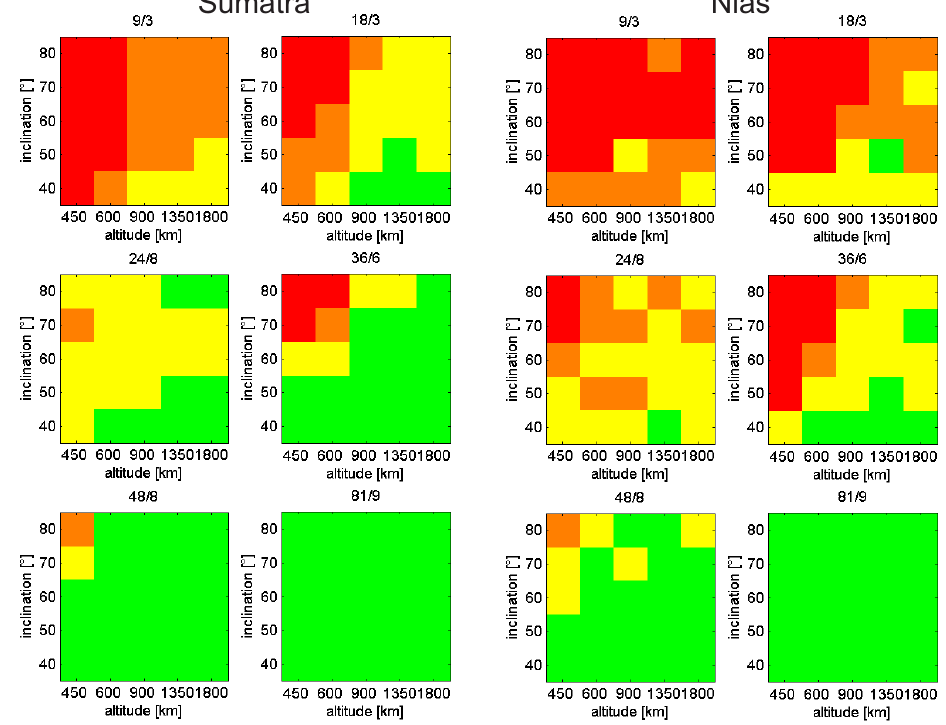
Fig. 10. Maximum detection times of six GNSS-R Walker constellation scenarios (Table 3) for all combinations of orbit altitude and inclination angle when applied to the Sumatra tsunami (left) and the Nias tsunami (right) with 20cm altimetric sensitivity assumption. Green boxes indicate a certain detection of the tsunami within 15min after the earthquake, yellow indicates detection within 30min, orange within 45min and red beyond 45min or no detection at all.